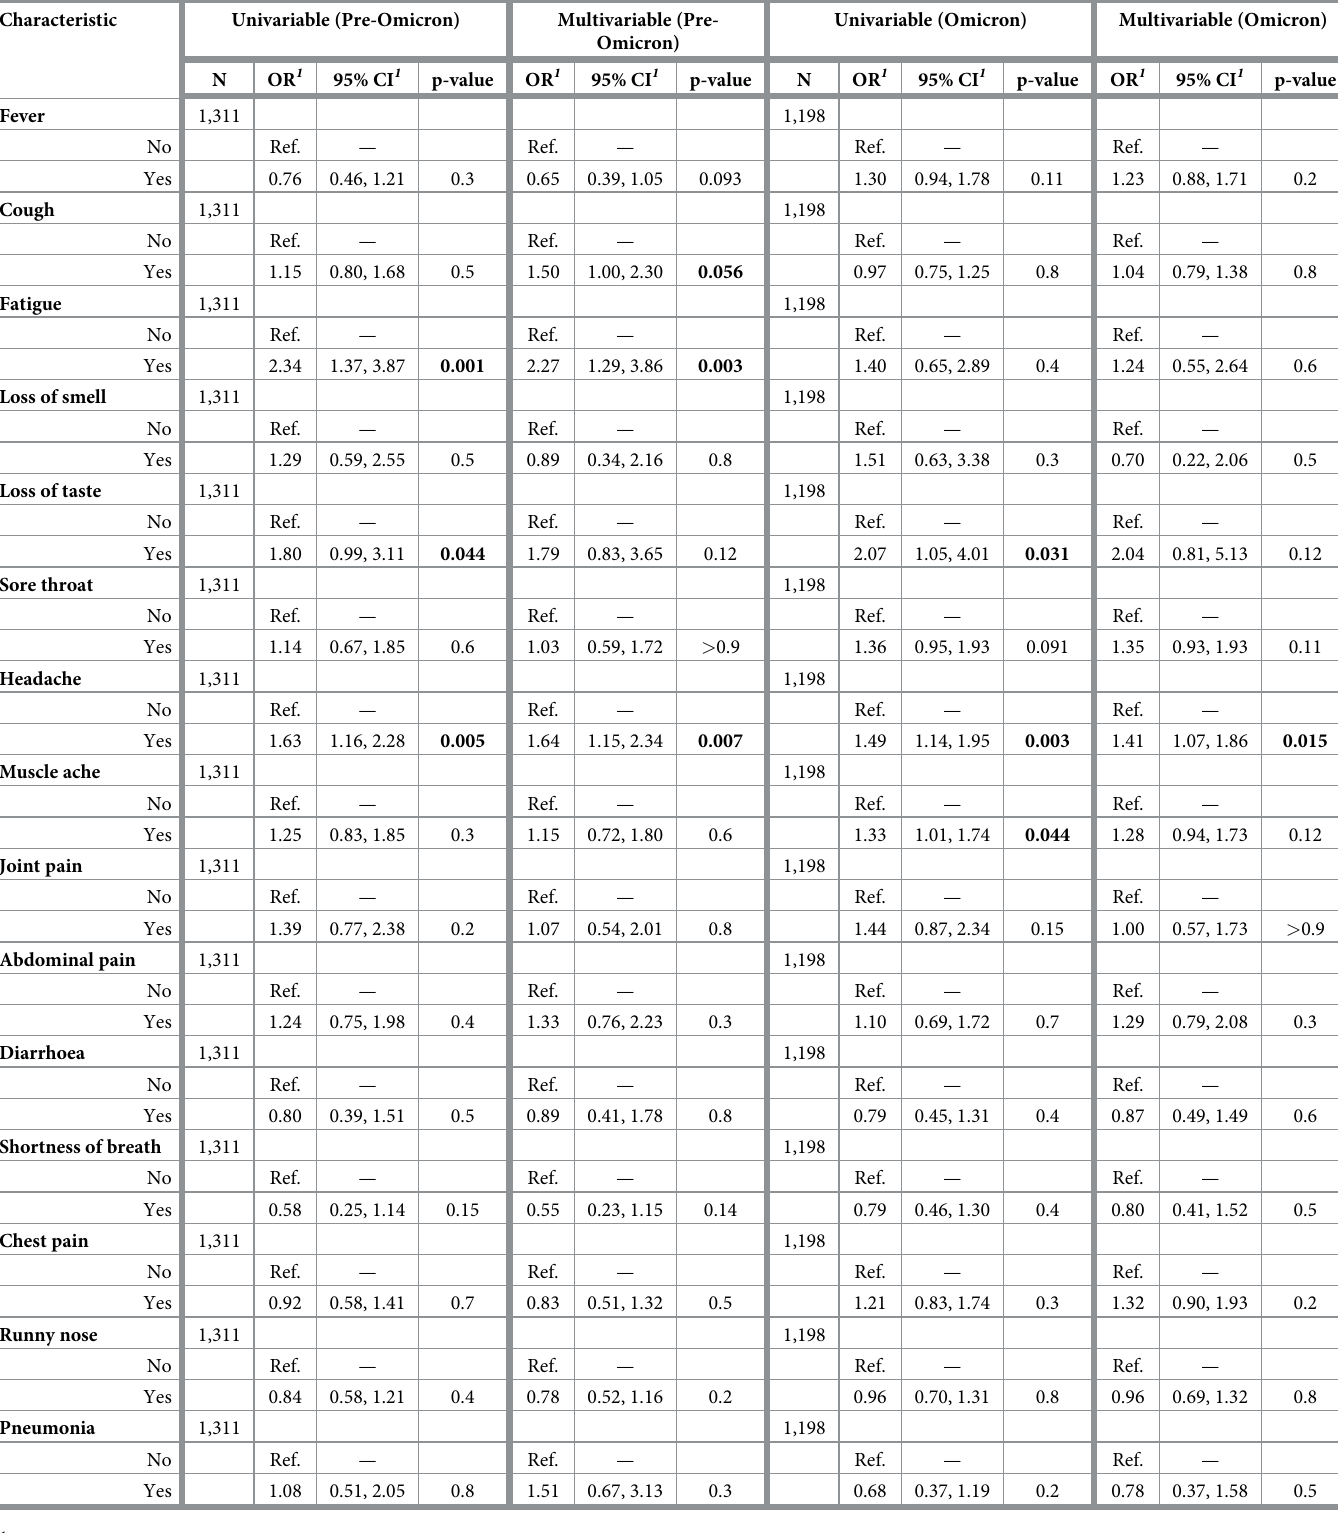
Table 2. Symptoms associated with SARS-CoV-2 infection.